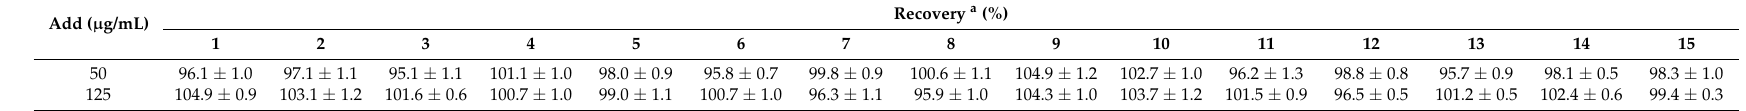
Table 3. Recoveries for stilbenoids ( 1 – 13 ) and dihydroisocoumarins ( 14 and 15 ) from the bark of Shorea roxburghii